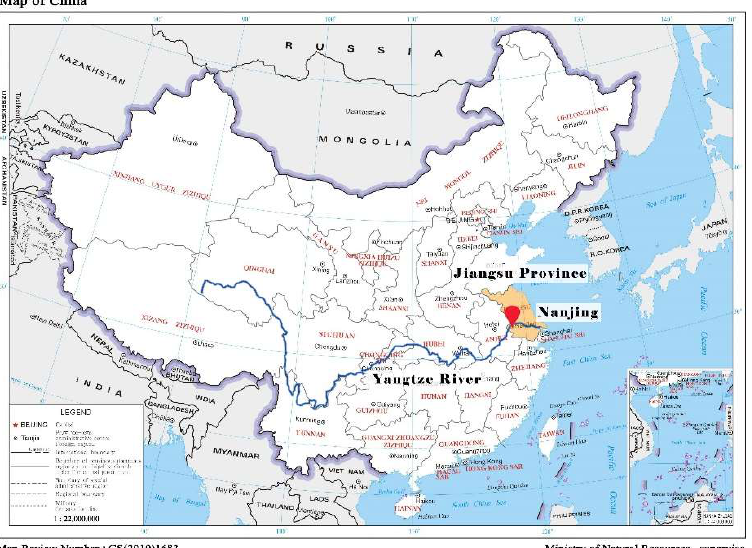
Figure 1. Location of Nanjing in China (based on a map of the People’s Republic of China by the State Bureau of Surveying and Mapping, map approval number: GS (2019)1683).